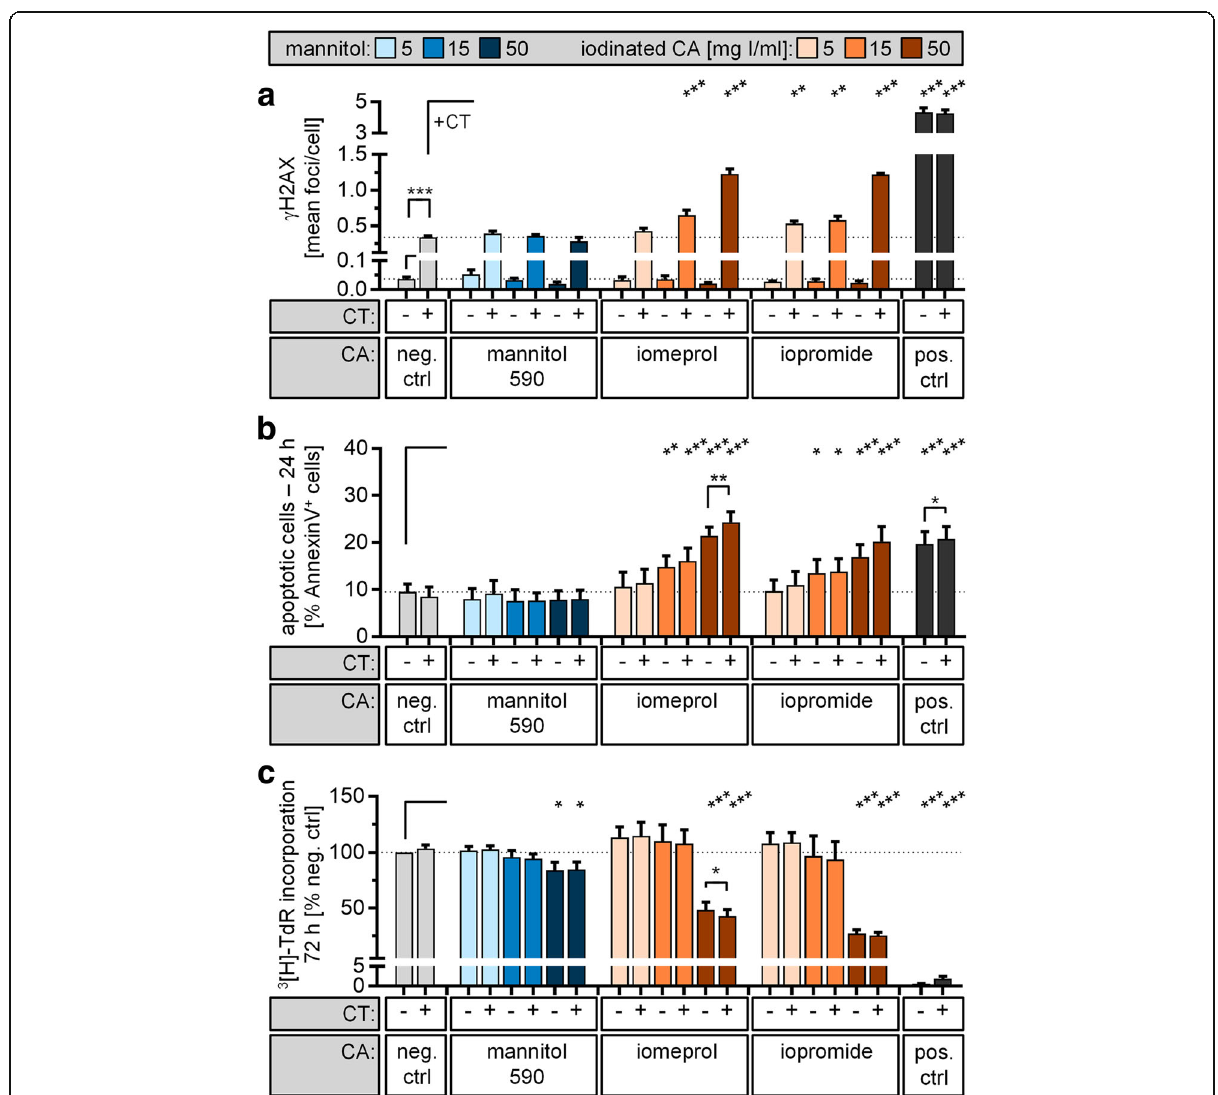
Fig. 1 Genotoxic and cytotoxic impact of contrast-enhanced CT exposure. Isolated lymphocytes were incubated with indicated concentrations of iomeprol or iopromid. Samples incubated in cell culture medium only ( neg. ctrl ) or with mannitol solution with the same osmolality as iopromide (590 mOsm/kg H 2 O) served as negative controls. Additionally, samples were either irradiated by a thorax CT scan ( + ) or placed outside the CT scanner (-) at the same temperature. a The level of DNA double-strand breaks was assessed 15 min after CT exposure by γ H2AX staining and automated foci quantification. Lymphocytes irradiated with 0.5 Gy served as positive controls ( pos. ctrl ). b Apoptosis rate was quantified after 24 h by Annexin V/propidium iodide staining combined with flow cytometric analysis. Samples incubated with 2 μ M camptothecin served as positive controls. c For proliferation analysis, lymphocytes were activated with PHA directly after CT exposure. Level of DNA synthesis was determined after 72 h by [ 3 H]-thymidine incorporation. Lymphocytes treated with 2 μ M camptothecin served as positive controls. Diagrams displays mean ± standard error of the mean of four experiments (*** p ≤ 0.001; ** p ≤ 0.01; * p ≤ 0.05) and raw data are listed in Additional file